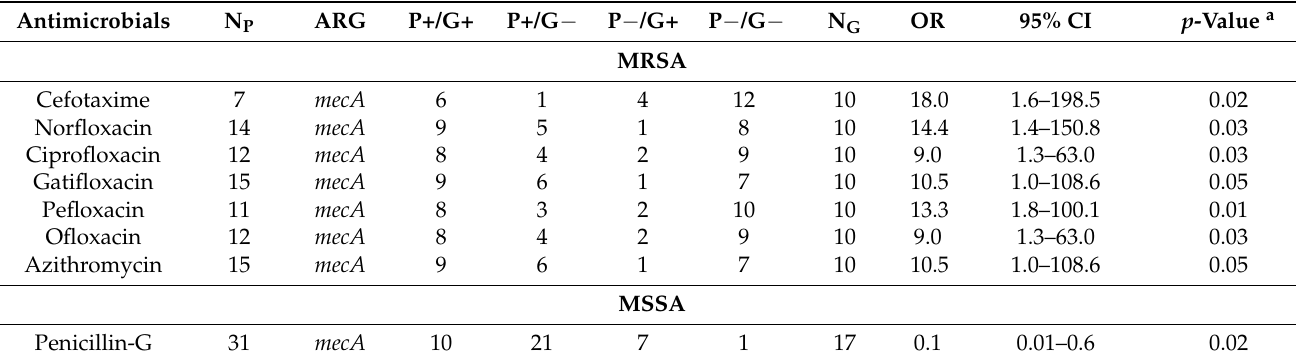
Table 3. Association between antimicrobial resistance phenotypes and methicillin resistance mecA gene in MRSA and MSSA isolated from frozen chicken meat.